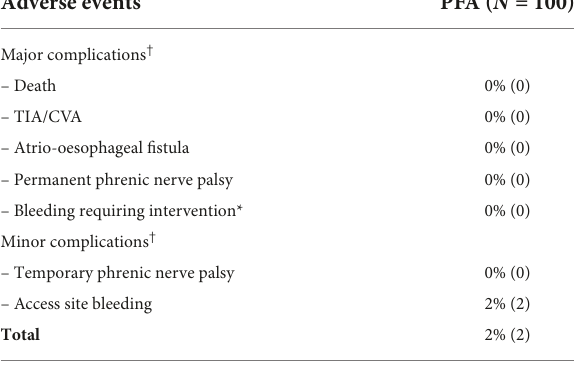
TABLE 3 Rate of procedural